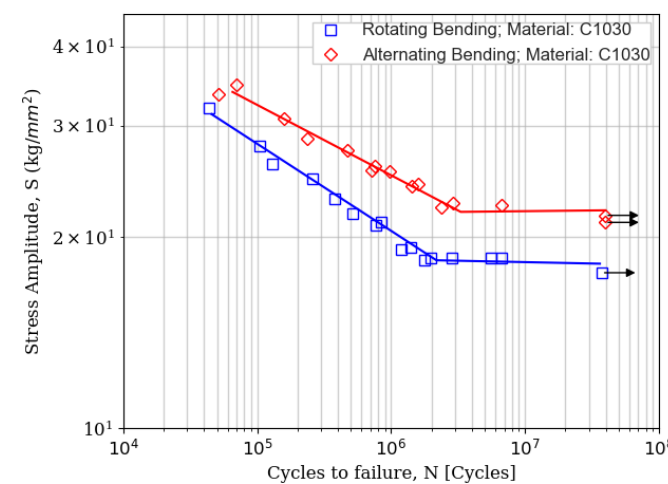
Figure 12: Comparison of rotating and alternating bending fatigue tests for the same loading; the difference has been attributed to (a) difference in presentation of the results or (b) difference in the fatigue process itself [23].